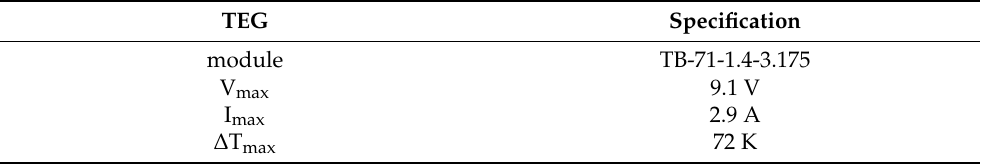
Table 3. Parameters from datasheets